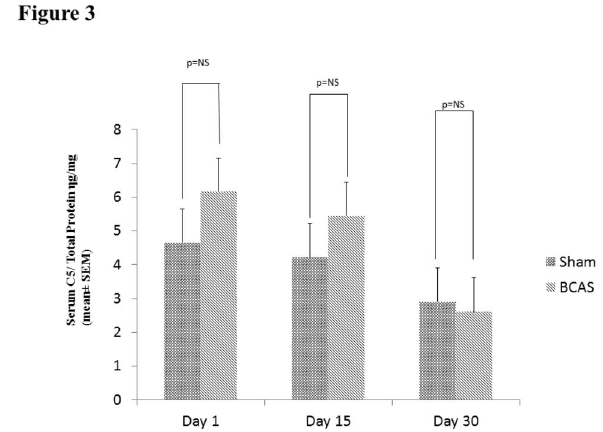
Figure 3. Serum C5 levels. Serum C5 measured by ELISA on day 1 (n=4), 15 (n=3), 30 (n=3) for sham and BCAS mice (mean ±SEM).